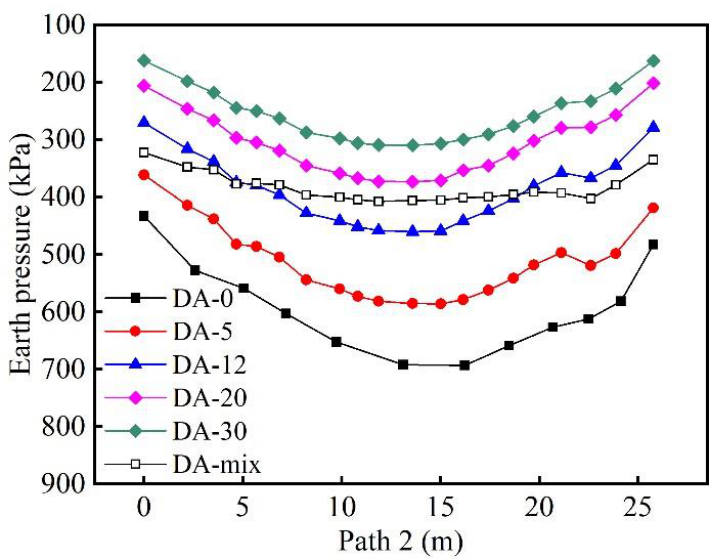
Figure 11. Curve of earth pressure along path 2 .